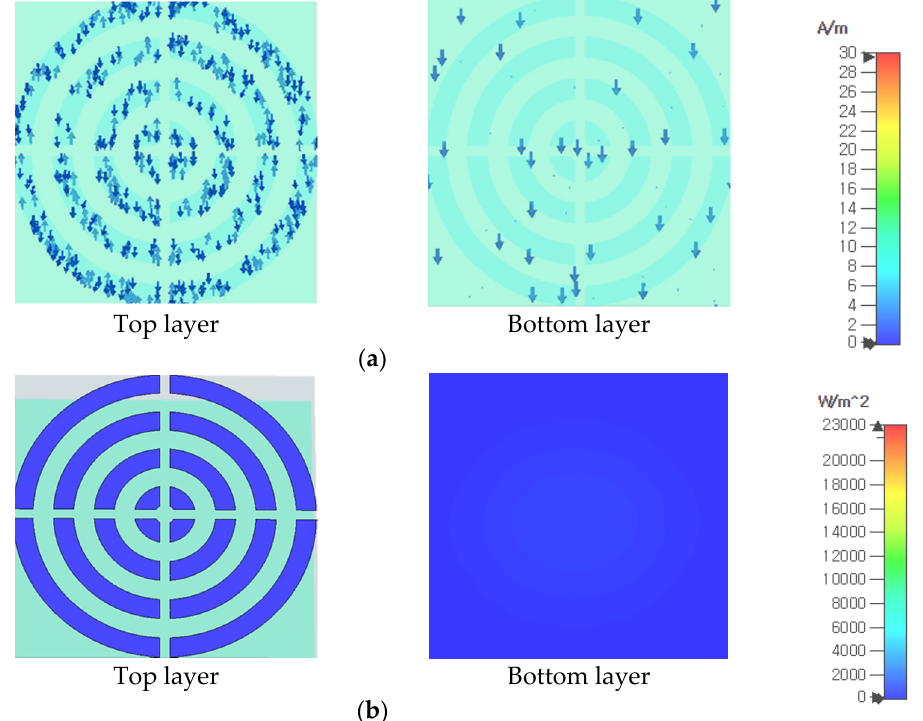
Figure 5. Study of the frequency of 2 GHz with a low absorbance. ( a ) Surface current distribution, and ( b ) surface power loss.